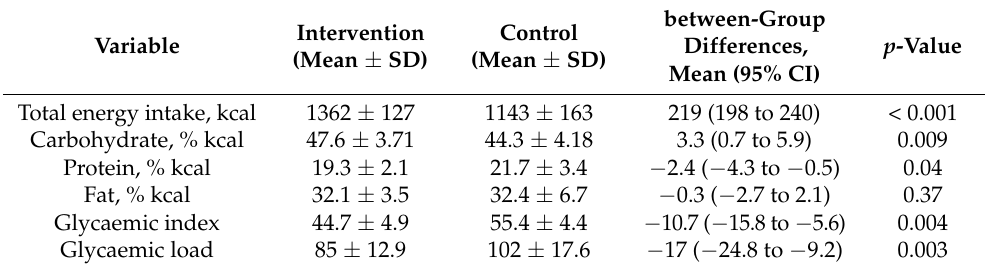
Table 5. Dietary intake of under-reporters of intervention and control groups during post- intervention.